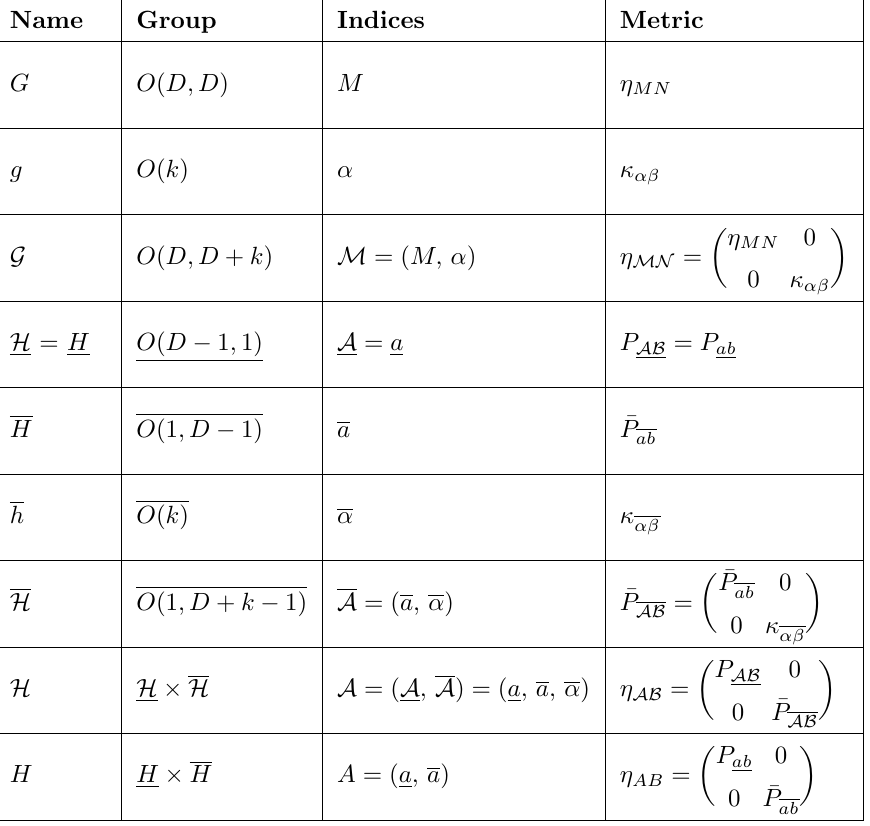
Table 1 . Notation used throughout the paper. Modulo a few exceptions, calligraphic letters refer to the extended space while conventional ones to the double space. The metrics and their inverses are used to raise and lower